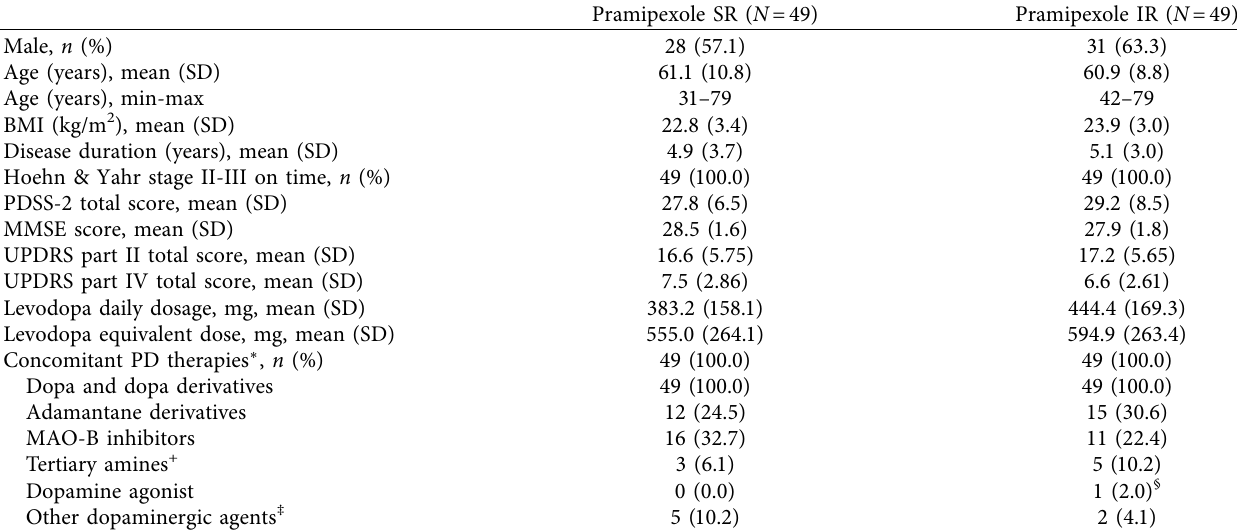
Table 2: Demographics and baseline characteristics (TS).